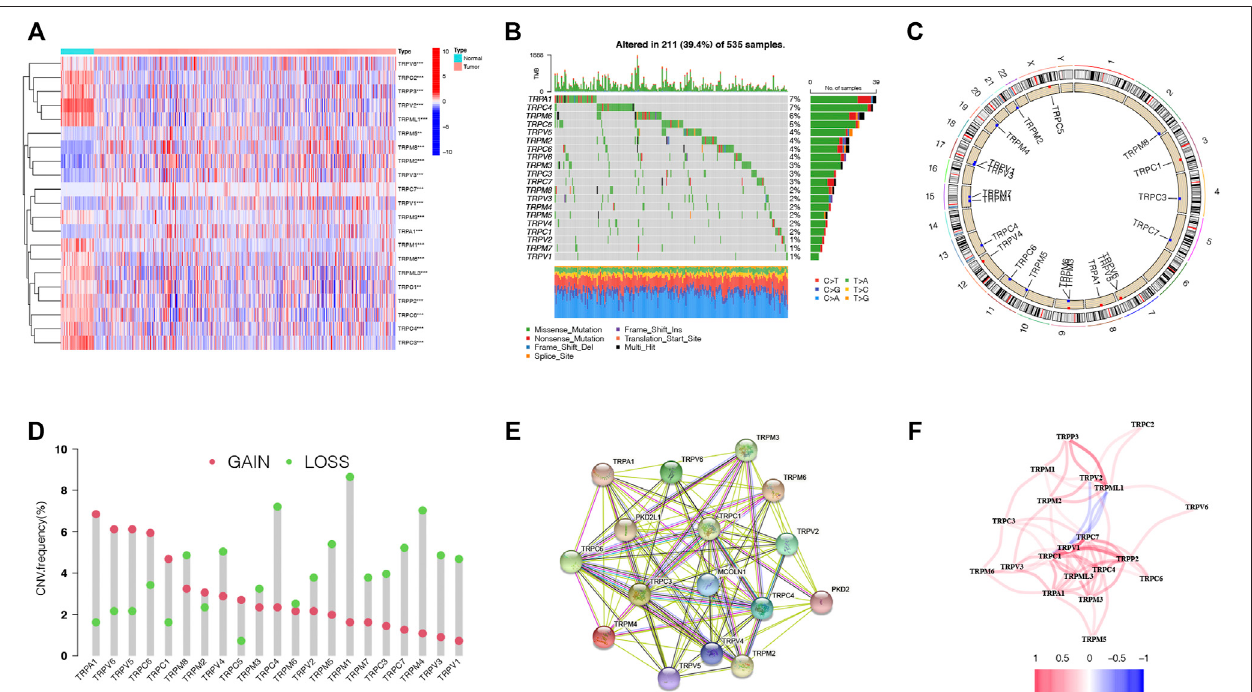
FIGURE 1 | Expressions and correlations of 28 TRP genes in LUAD. (A) . Heatmap (red: high expression; blue: low expression) of the TRP genes between normal lung tissues (N, blue) and LUAD tissues (T, red). p values were demonstrated as ** p < 0.01; *** p < 0.001. (B) . Mutation frequencies of TRP genes in LUAD patients from the TCGA cohort. (C) . Locations of CNV variations in TRP genes on 23 chromosomes. (D) . Frequencies of CNV, non-CNV and gain and loss CNV, among TRP genes. (E). PPI network demonstrating the interactions of the TRP genes (interaction score = 0.9). (F) . TRP gene correlation network (red string: positive correlation; blue string: negative correlation. The shades of the colors represent the correlation